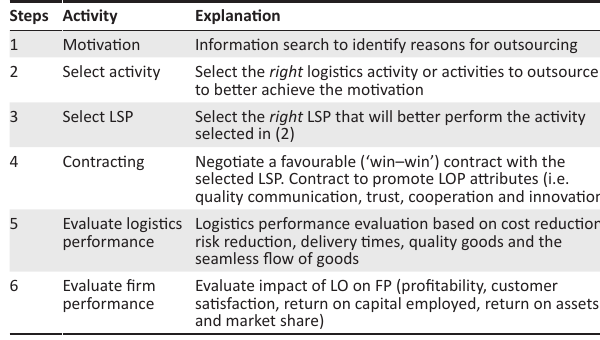
FIGURE 3: Logistics outsourcing critical path model for small and medium-sized